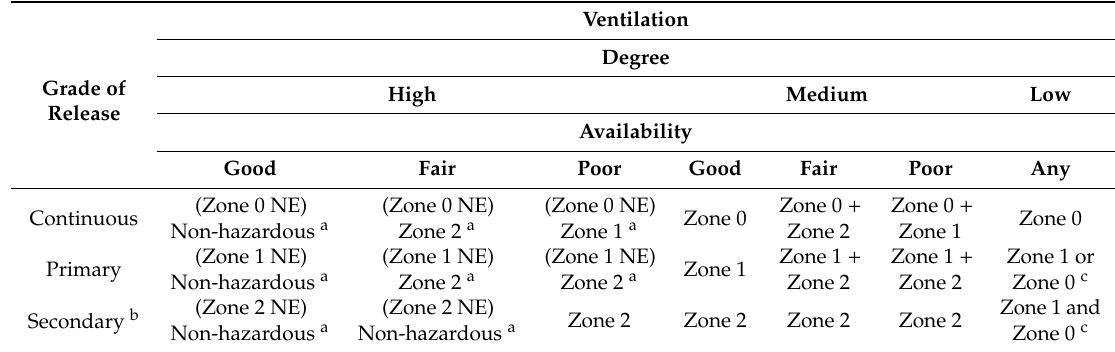
Table 5. Influence of the ventilation on the type of